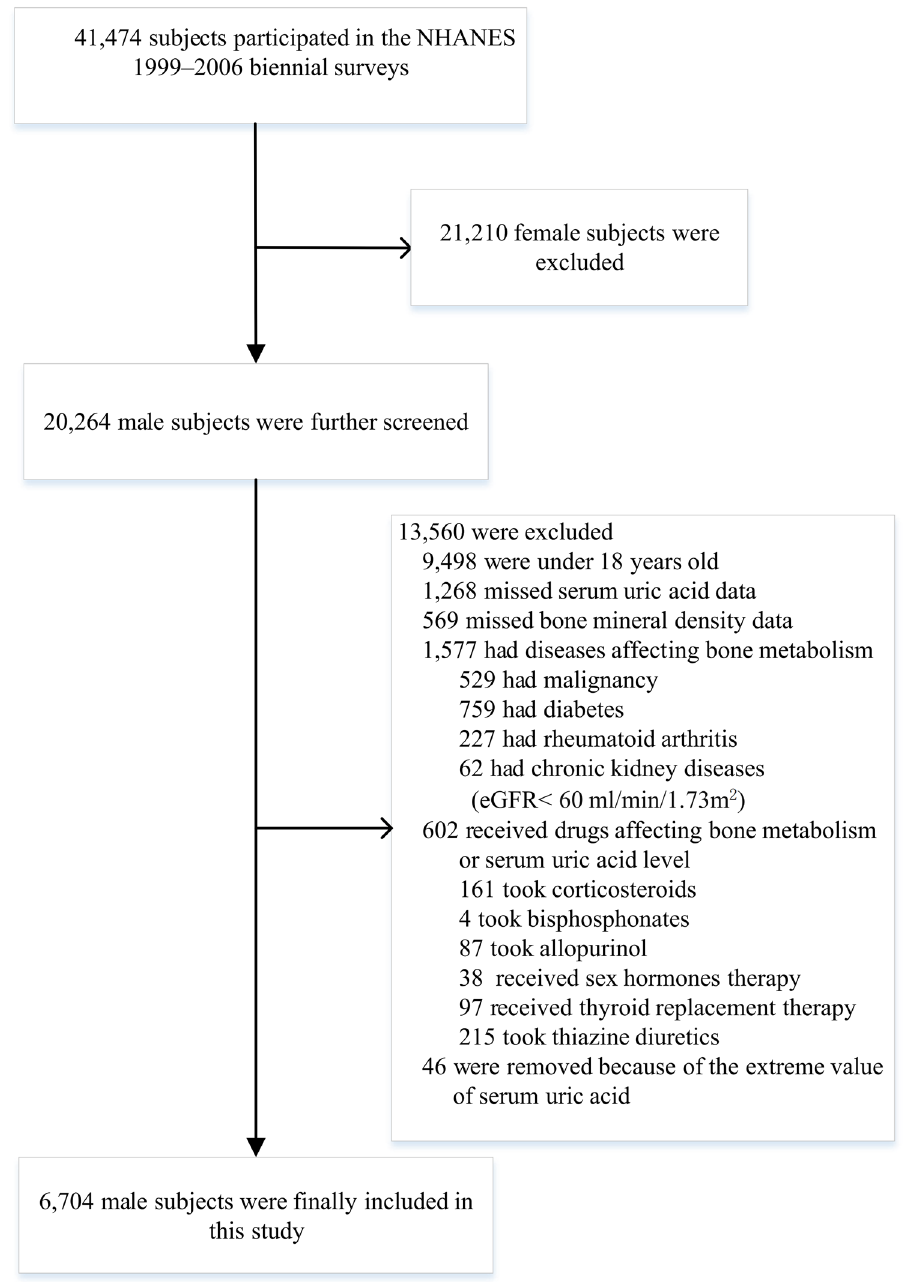
Figure 1. Selection of study participants in the National Health and Nutrition Examination Survey (NHANES, 1999–2006). eGFR estimated glomerular fltration